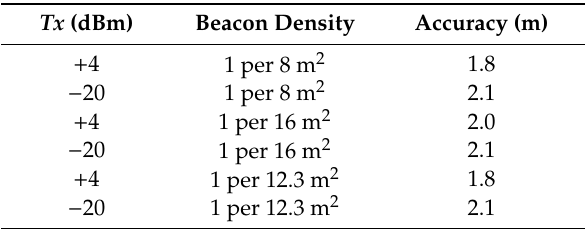
Table 31. Influence of Tx and beacon density on positioning accuracy with beacons integrating